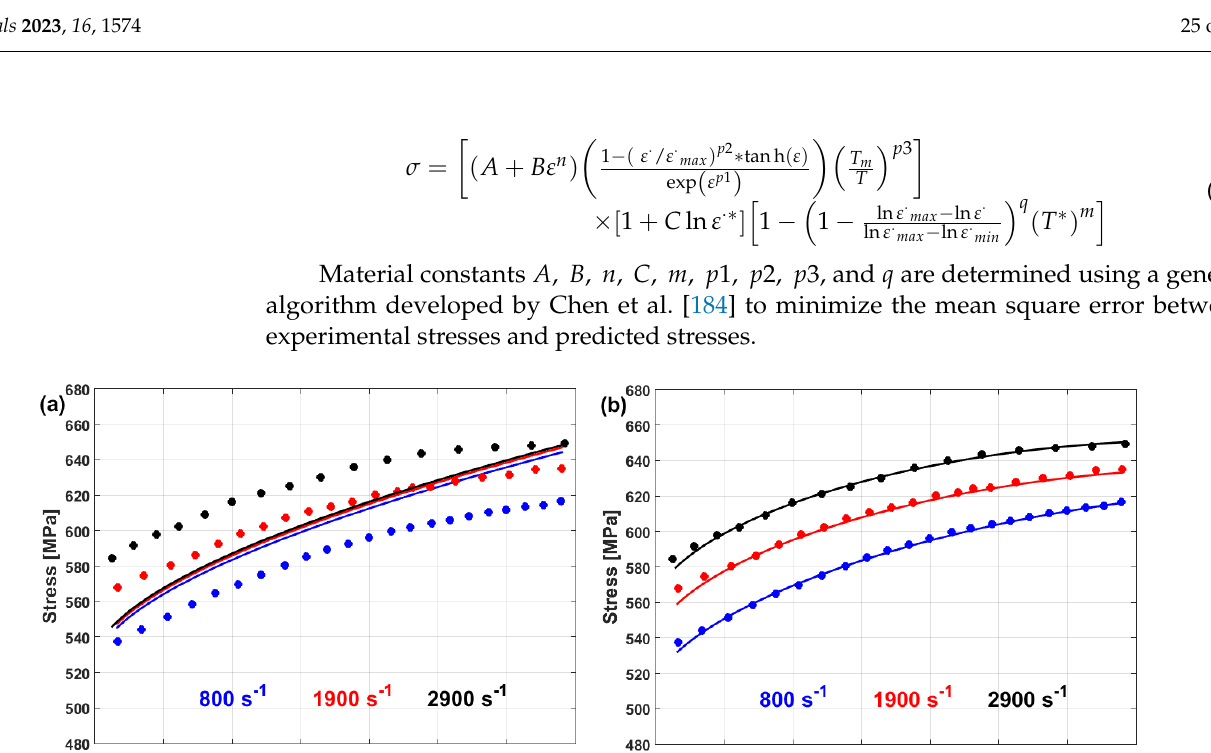
Figure 29. Determination of 𝐶(𝜀, 𝜀 ∙ ) ( a ) 𝐶 vs. 𝜀 and ( b ) 𝐶 vs. 𝜀 ∙ .